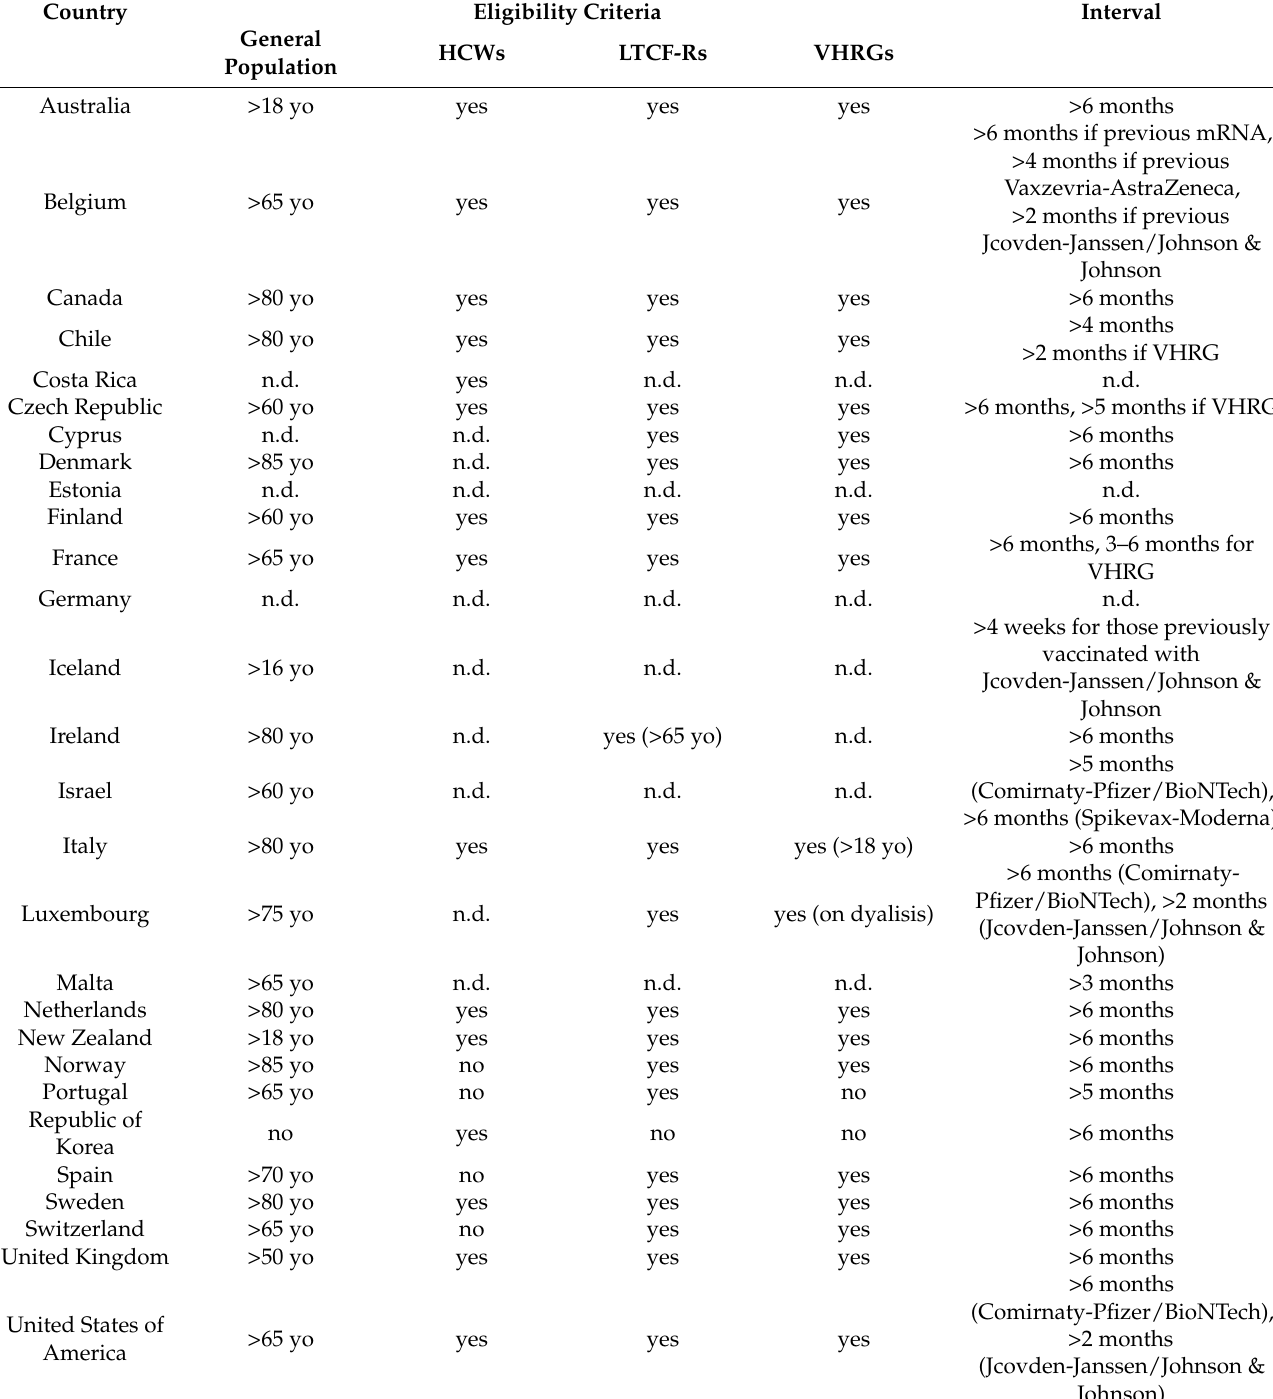
Table 3. Administration of a booster dose of a vaccine against COVID-19: first recommendations regarding eligibility criteria and interval by